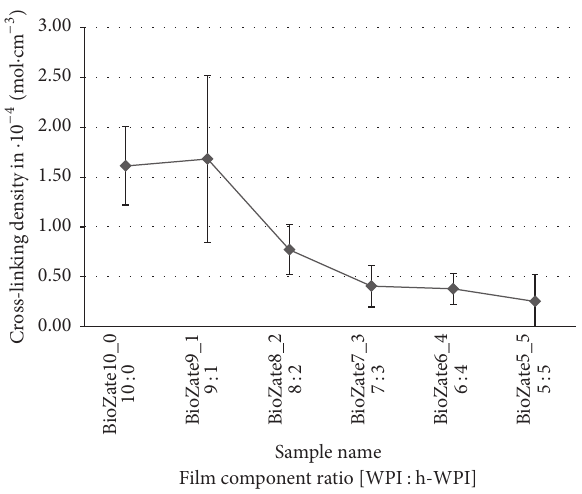
Figure 2: Cross-linking density of all samples in mol ⋅ cm −3 with 95% confidence intervals.